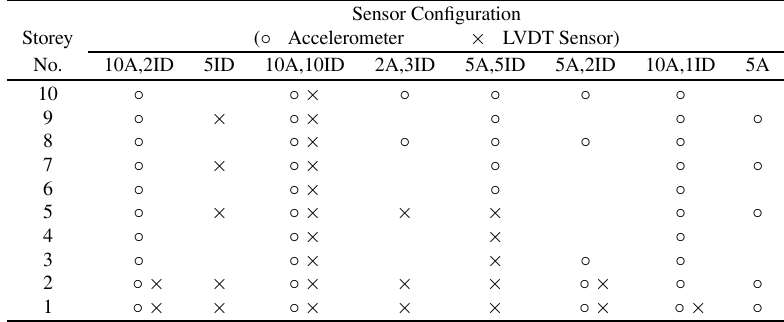
Table 8 Sensor con fi gurations with two dampers